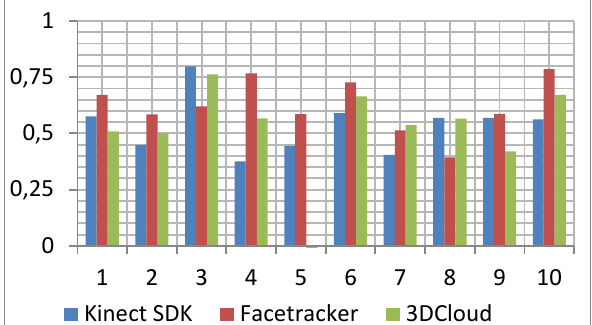
Figure 21. Mean correlation for the pitch for each candidate.